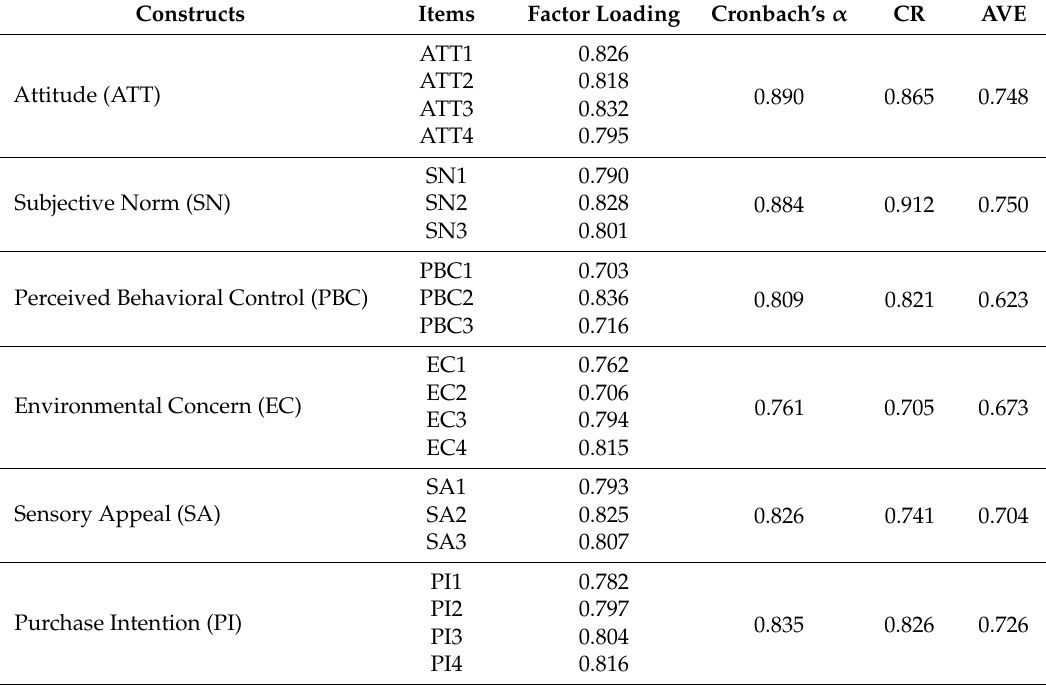
Table 3. Results of factor loading, reliability and validity.